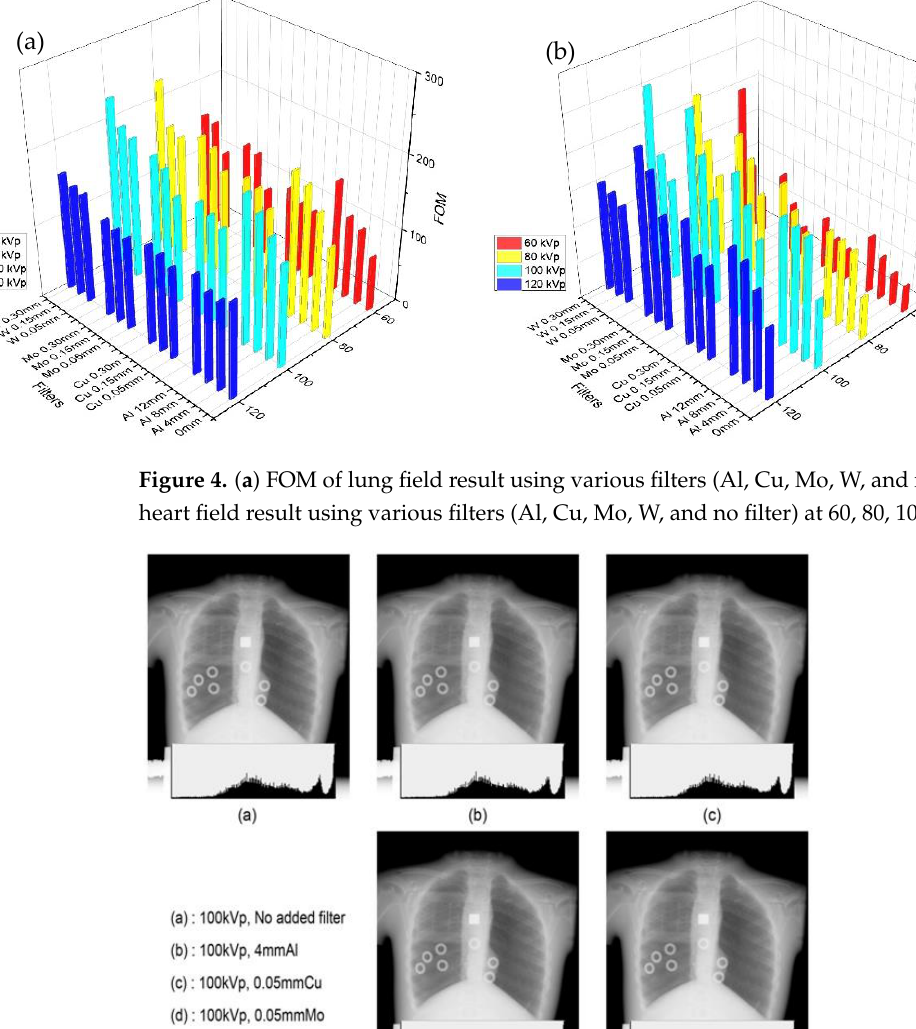
Figure 4. ( a ) FOM of lung field result using various filters (Al, Cu, Mo, W, and no filter), ( b ) FOM